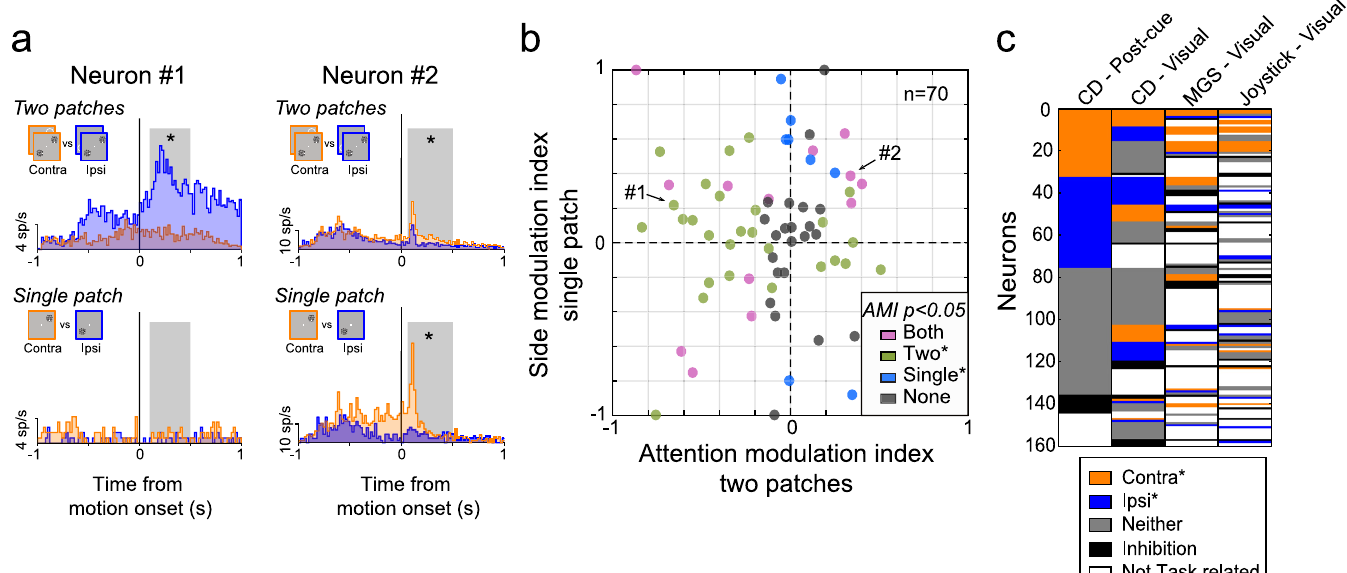
Fig 3. Dependence of caudate visual activity on the presence of distracters. (A) Firing rates for two sample caudate neurons aligned on presentation of visual stimuli for the two-patch condition (top row) and single-patch condition (bottom row). The orange/blue code indicates respectively the spatial cue location or the single patch location for contralateral (“contra”)/ipsilateral (“ipsi”) side. Gray boxes demarcate the 0.4-s time period used for computing the AMI for the two-patch condition and SMI for the single-patch condition. Asterisks indicate significant values for AMI/SMI (Wilcoxon rank, p < 0.05). (B) Scatter plot of AMI and SMI values computed for each caudate neuron with visual activity ( n = 70). AMI values on the x-axis greater (less) than 0 indicate preference for contralateral (ipsilateral) hits in the two-patch condition. SMI values on the y-axis greater (less) than 0 indicate preference for contralateral (ipsilateral) for single-patch condition. Each dot represents one caudate neuron from the "visual" subpopulation (Fig 2B, n = 70). Color indicates the neuron’s group assignment based on the AMI/SMI values: AMI for two patches different for one side (green), both different from chance (purple), SMI for single patch different for one side (blue), and neither different from chance (gray). (C) Side preference for the motion CD task, MGS task, and joystick task in the population of 160 caudate neurons tested with the three tasks. Each row represents a single neuron across different visual epochs: post-cue and visual for CD task and visual periods for MGS and joystick mapping task. Neurons were sorted according their side preference for post-cue period. Colors indicate side preference (orange for contra, blue for ipsi, gray for neither) when the activity was significantly greater than the baseline (Wilcoxon rank sum test, p < 0.05), when no significant activity was reported (Wilcoxon rank sum test, p � 0.05; white), or when activity was significantly lower than the baseline (Wilcoxon rank sum test, p < 0.05; black). We used all trials (hits, misses, false alarms, and correct rejects) for the CD trials and all correctly performed trials for the MGS and joystick tasks. Underlying data available in S1 Data. AMI, Attention Modulation Index; CD, change-detection; MGS, memory-guided saccade; SMI, Side Modulation Index; sp/s, spikes per